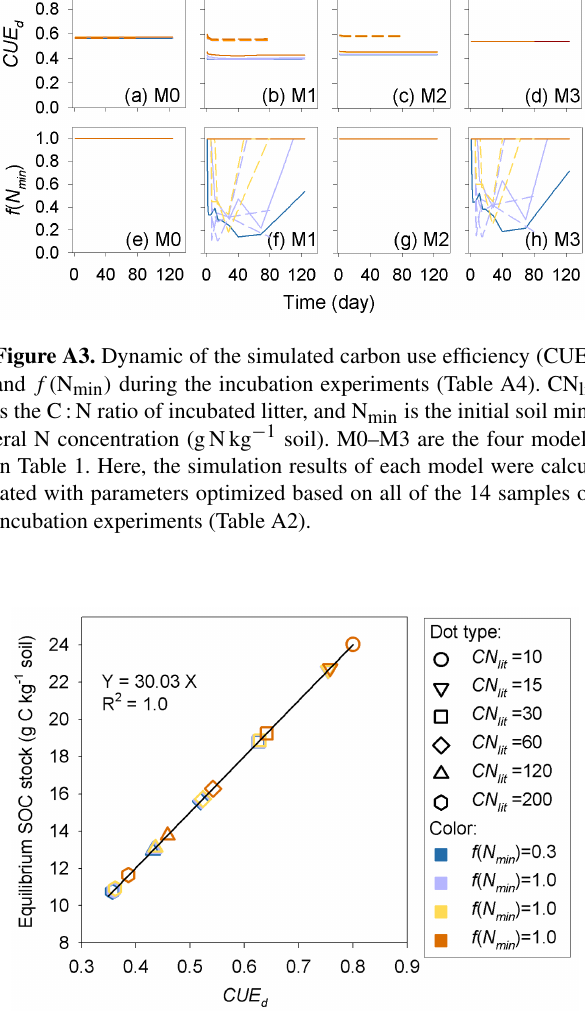
Figure A4. Relationship between C stock of the potentially equi- librated SOM pool and the carbon use efficiency of decomposed metabolic litter (CUE d ) at the dynamic equilibrium stage. f ( N min ) denotes the inhibition factor (0–1) of soil mineral N on litter decom-